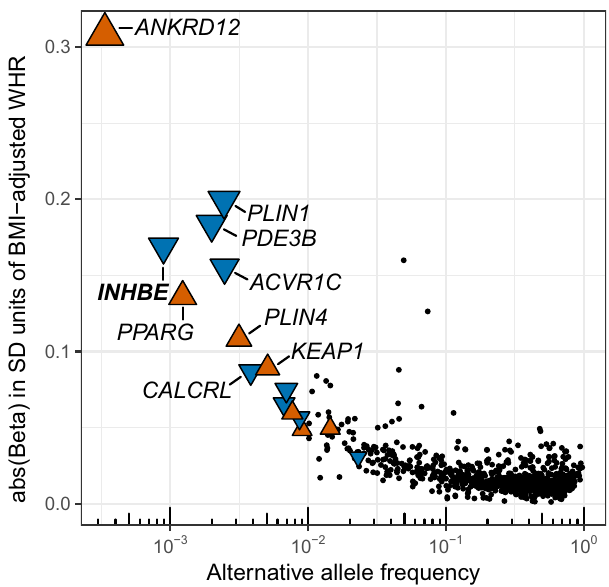
Fig.2|AssociationswithBMI-adjustedWHRforcommonandrareallelesinthe multi-ancestry analysis. The 16 genes with exome-wide signi fi cant gene-burden associations are shown as colored triangles, with the triangles pointing upwards (orange) or downwards (blue) indicating associations with higher and lower BMI- adjusted WHR, respectively. The 868 fi ne-mapped common variants are indicated as black dots. The alternative allele frequency for each variant or gene-burden genotype isindicated on the x -axis. SD standard deviation, WHR waist to hip ratio, BMI body mass